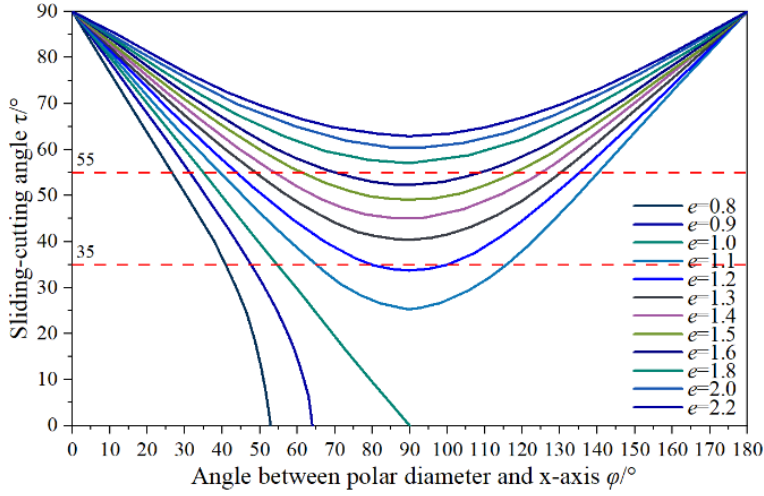
Figure 3. Variation law between sliding–cutting angle and angle between polar radius and x -axis. In order to reduce the plant entanglement at the root of the rotary blade, the sliding– cutting angle needs to meet the conditions of uncut plant stems sliding out. Since the tool holder is the secondary working area, the blade length in this area can be reduced, and the sliding–cutting angle should be increased quickly. When the plant stems move to the middle of the cutting edge, the sliding–cutting angle should increase slowly with the increase of the pole radius. The plant stems are cut off or slide out of the rotary tillage area along the cutting edge due to the pushing action. According to the requirements of Cyperus esculentus harvesting and the variation law of eccentric circle τ c- ϕ , the coefficient of excentralization of sections AB and BC was 1.2 and 1.6. In order to prevent the tool